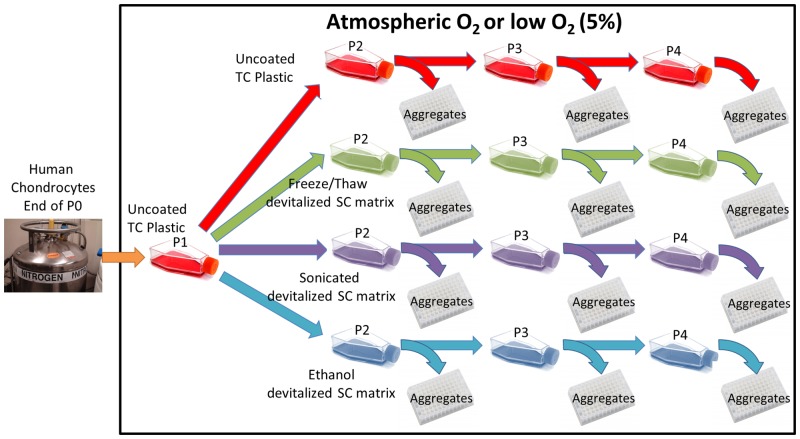
Experimental culture conditions overview.Human articular chondrocytes were thawed from frozen stocks and initially expanded on TC plastic before being split between each of the surfaces (TC plastic, F-SCM, S-SCM and E-SCM) and expanded for 3 passages with aggregates made at each passage. All steps were conducted at either (20%) atmospheric or low (5%) O2 tension.